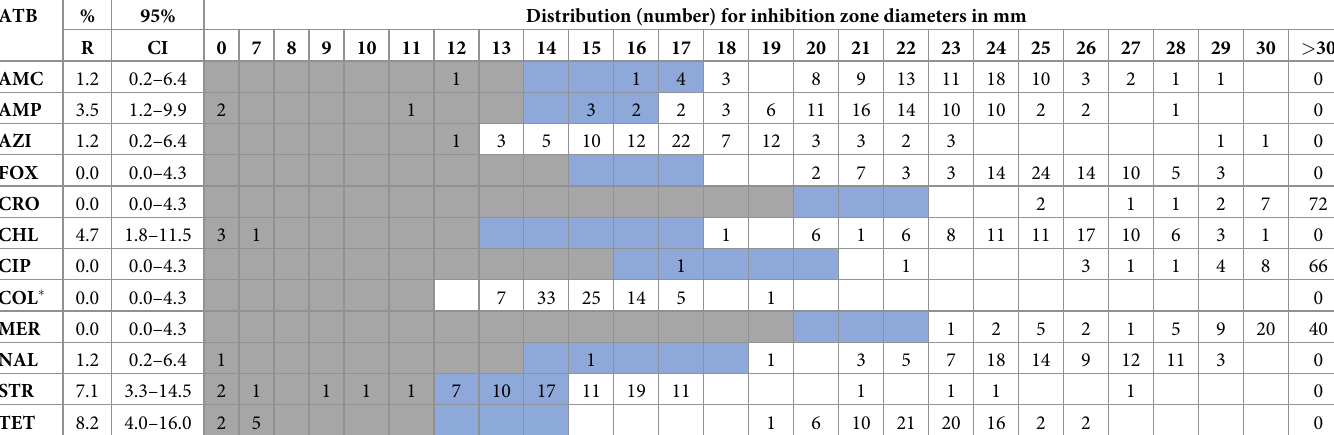
Table 2. Distribution of inhibition zone diameters of non-type-specific E . coli (n = 85) isolated on plain MacConkey agar (without antibiotic).